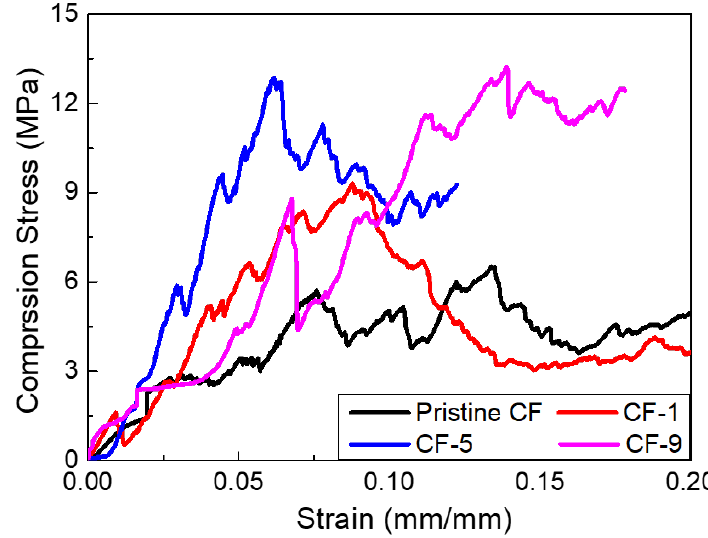
Figure 6. Comparison of compression strength of pristine CF and modified mCF materials with different PR additive.